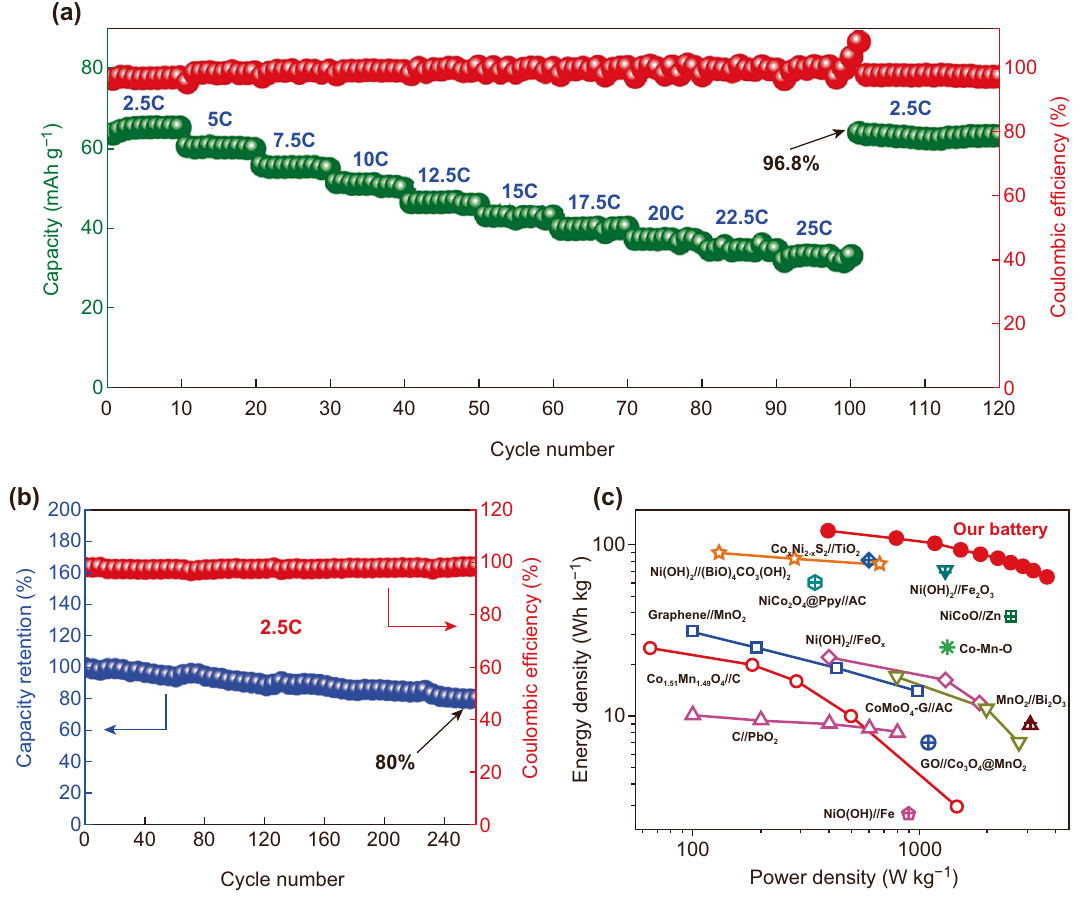
Fig. 4 a Rate capability of the ZIB ranging from 2.5 to 25 C. b Capacity retention and corresponding coulombic efficiency of ZIB upon long cycles. c The Ragone plot of our work with others reported in previous